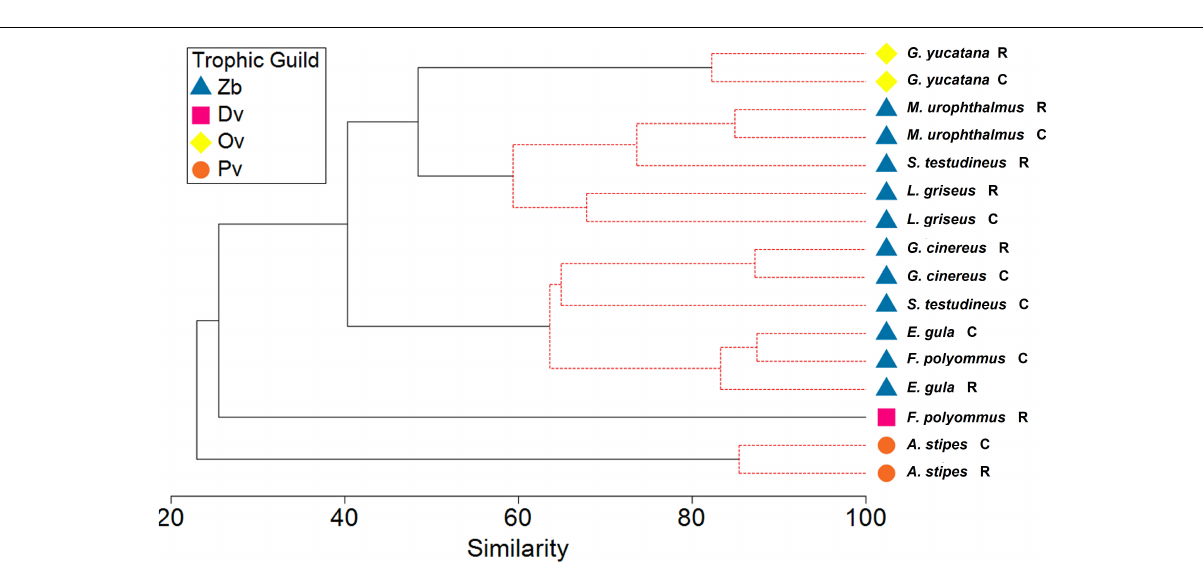
FIGURE 3 | Cluster analysis showing the groups by trophic guilds of the fish species. Pv, planktivores; Dv, detritivores; Ov, omnivores; Zb, zoobenthivores; C, conserved; R,